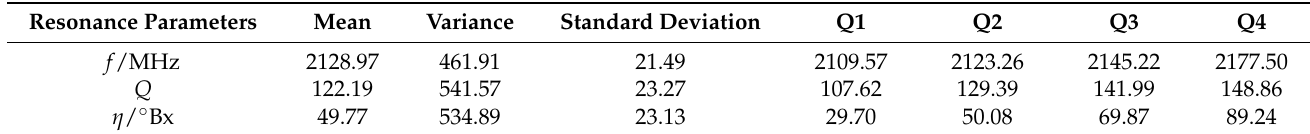
Table 3. Relevant statistical data of three resonance parameters.